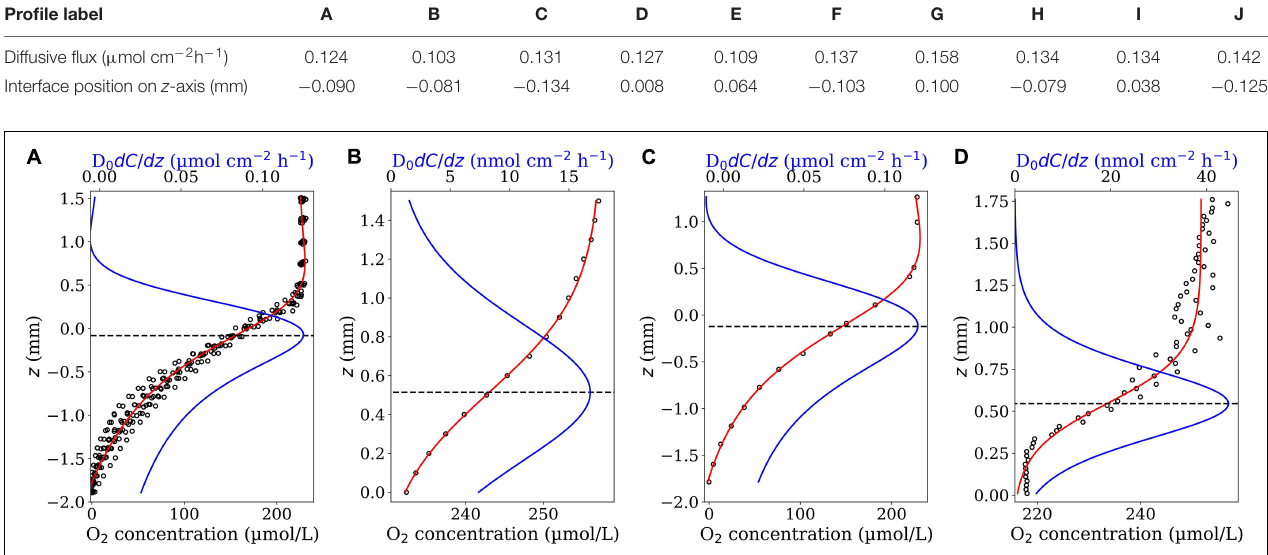
FIGURE 6 | Outputs of Derivative-Max model applied on different type of measured profiles: Replicated profiles (A) , low resolution profiles (B,C) , and noisy profiles (D) . The profiles in panel (A) are pooled data of all the 10 profiles shown in Figure 5 . Panels (B,C) show the profiles considered in Figures 2A , 5A in which every second data point has been removed, resulting a coarser profile of 100 µ m resolution for the considered aggregate (B) and ca. 200 µ m for the sediment (C) . Panel (D) shows an example noisy profile containing scattered data points. Eq. 7 and 4 (red curves) have been used to fit the profiles shown in (A,C) and (B,D) , respectively. Blue curves show the corresponding diffusive flux functions and the dashed lines determine the position of interface on the z -axis (corresponding to the maximum diffusive fluxes).